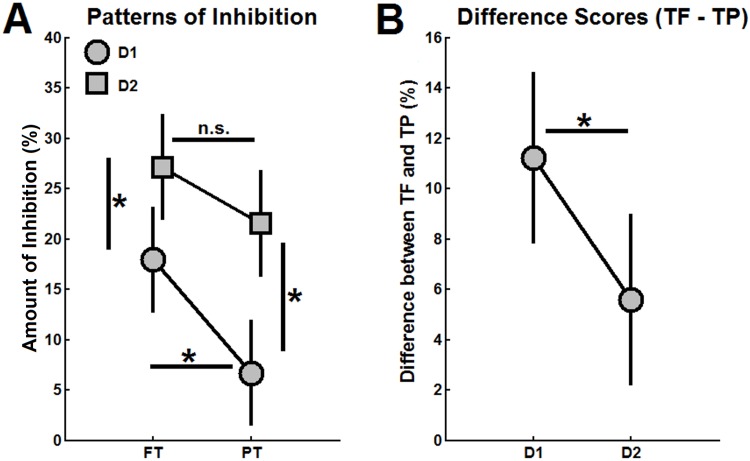
Condition means and interaction plot with 95% within-subjects CIs.(A) Average values of the amount of inhibition computed for D1 and D2 conditions during force and positions tasks (FT and PT), with 95% within-subjects CIs represented as error bars. B) Mean differences in the amount of inhibition between FT and PT conditions (error bars show the associated within-subjects 95% CIs). Asterisks indicate significant differences (p < 0.05) between conditions, as revealed by two-way ANOVA and simple effects tests. Not significant = “n.s.”